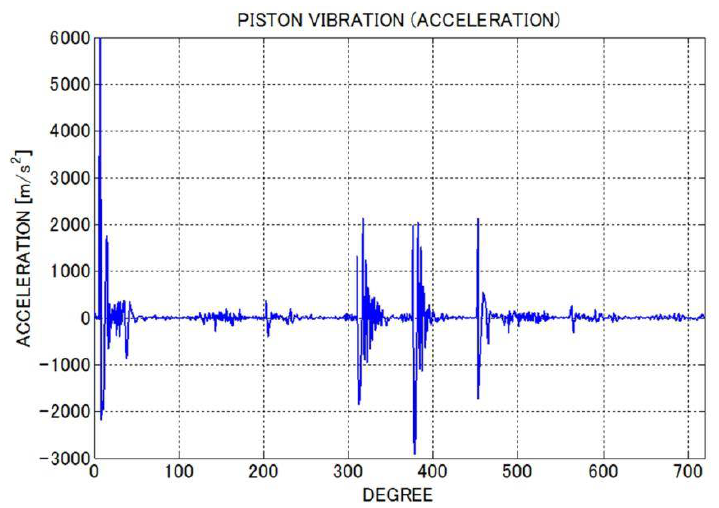
Figure 7. Vibration acceleration of the piston skirt at the lower part of the thrust side.